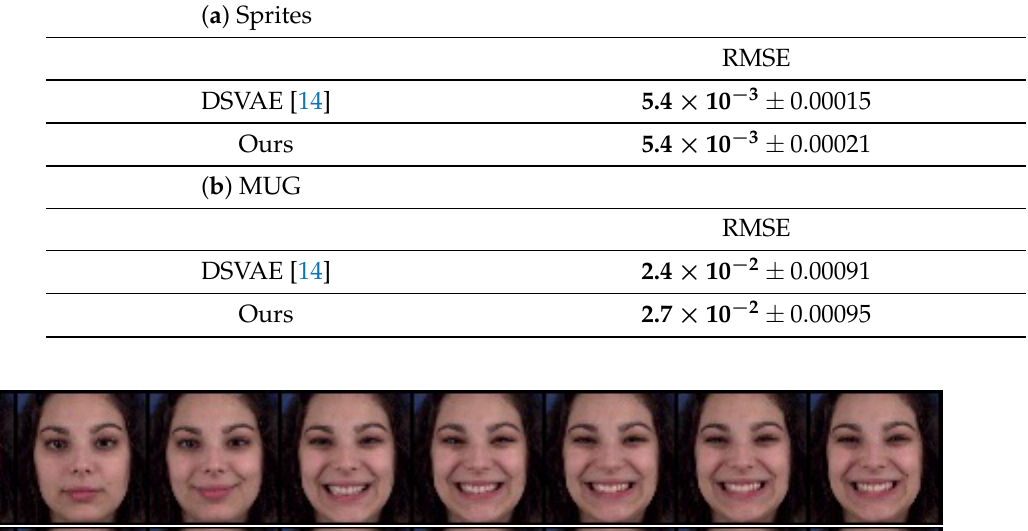
Table 3. Root-mean-squared error for reconstruction task.